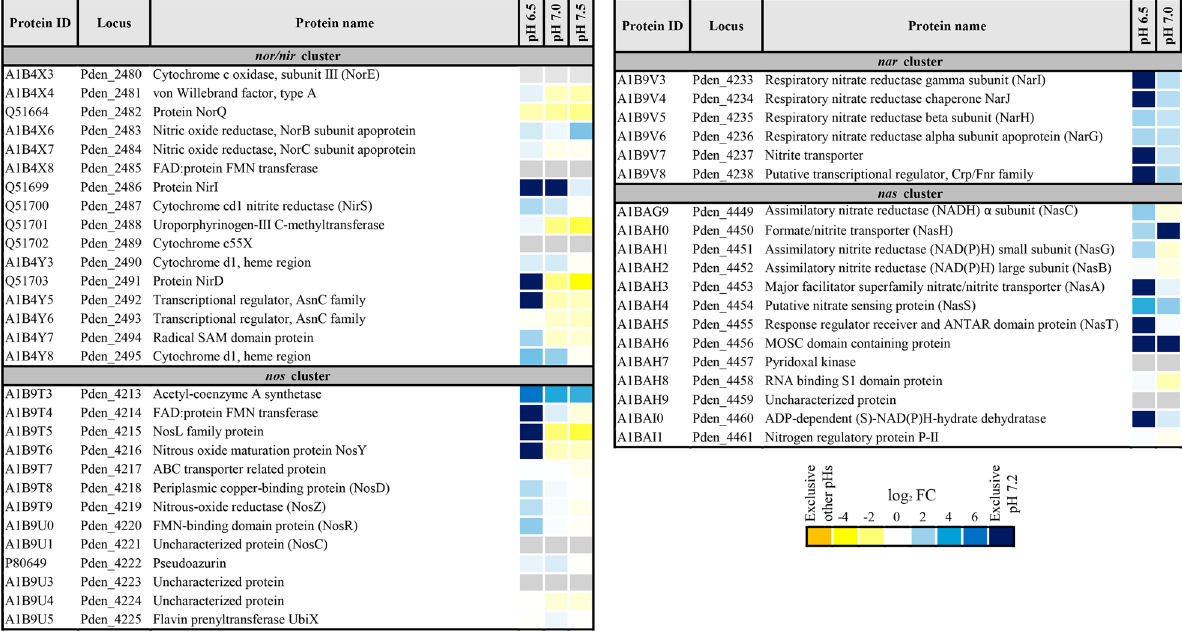
Figure 3. LC–MS/MS analysis of P. denitrificans proteins encoded by denitrification and nitrate assimilation gene clusters affected by pH. Heatmap shows the fold changes, represented as log 2 normalized expression using pH 7.2 as reference. Therefore, positive values correspond to proteins over-represented at pH 7.2 (blue) and negative values correspond to proteins over-represented at pH 6.5, pH 7.0 or pH 7.5 (yellow). Proteins with an absolute fold change > 100 are considered exclusive at pH 7.2 (dark blue) or exclusive at other pHs (orange). Grey color represents proteins not detected in this study. Protein code according to Uniprot database